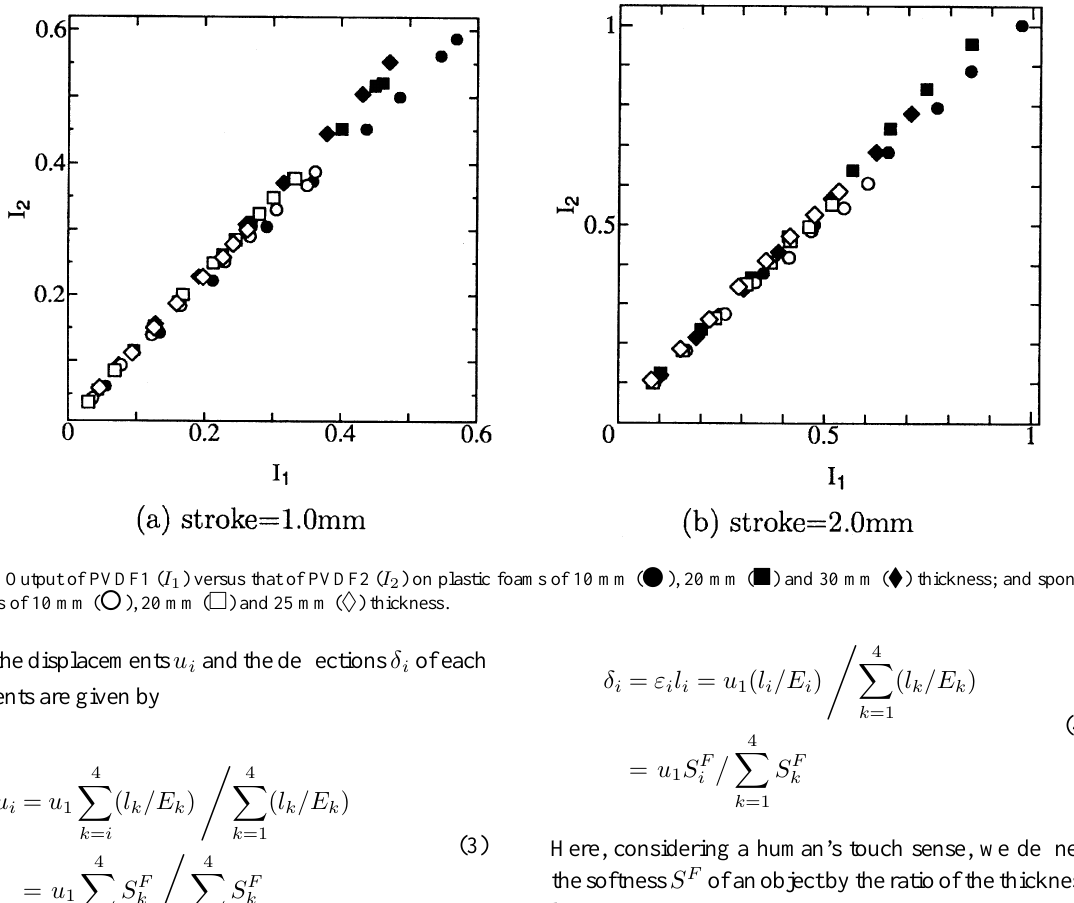
• ), 20 mm ( (cid:1) ) and 30 mm ( (cid:2) ) thickness; and sponge